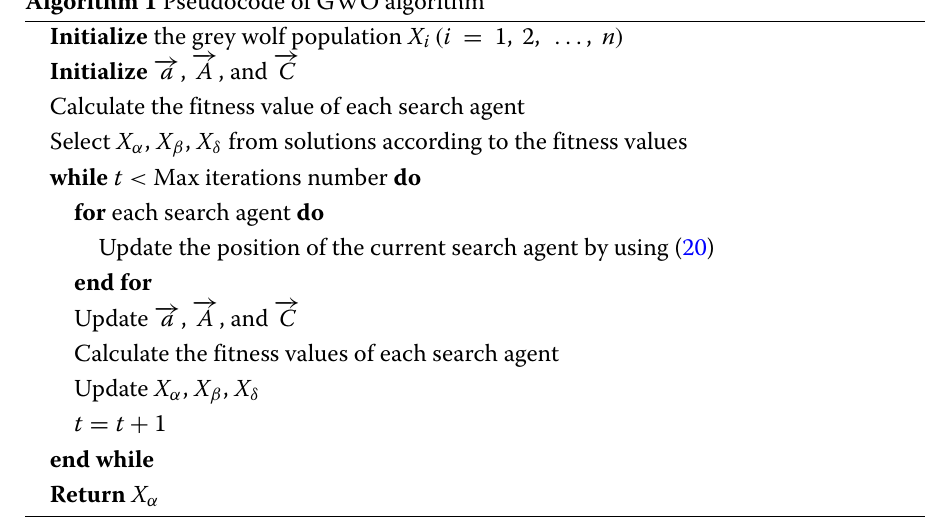
Algorithm 1 Pseudocode of GWO